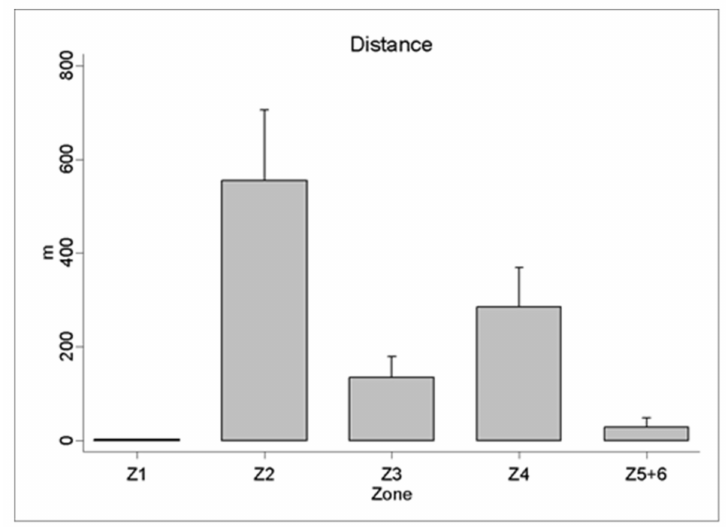
Figure 2. Activity profile during a beach handball game, expressed as the distance covered in different locomotor categories: zone 1: 0–0.4 km · h − 1 ; zone 2: 0.5–4 km · h − 1 ; zone 3: 4.1–7 km · h − 1 ;